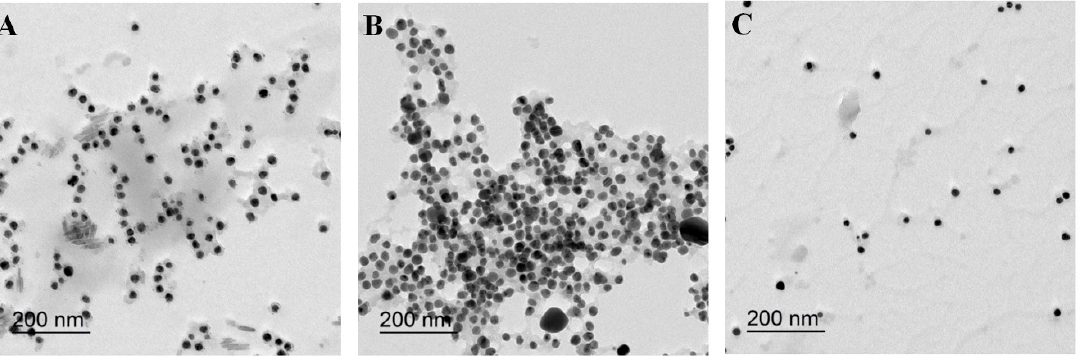
Figure 5. TEM images of polyDOPA-AgNPs in the presence of ( A ) Cu 2+ ; ( B ) Pb 2+ ; and ( C ) Cd 2+ ions (0.1 μ M).